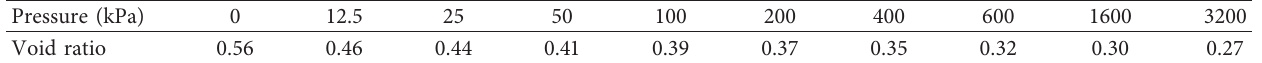
Table 3: Gravity fitting compression test pressure and porosity